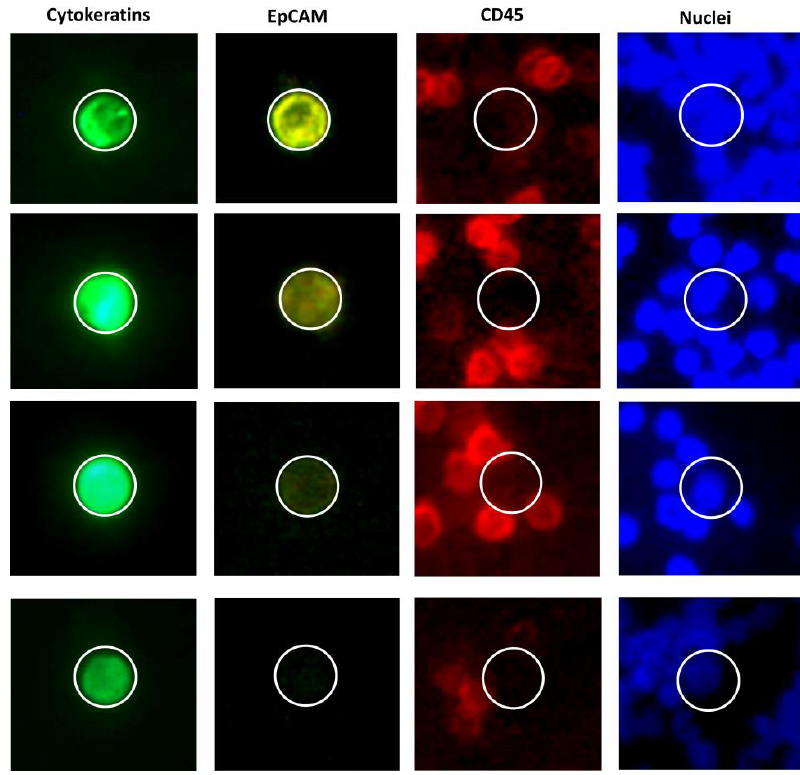
Figure 2. Heterogeneity of EpCAM expression in CTCs in metastatic breast cancer (luminal). Every set of images (Cytokeratins [pan-CK, EpCAM, CD45, nuclei [DAPI]) represents a CTC derived from a different patient. Most of the cytokeratin-positive cells have at least slight microscopically-detectable EpCAM expression, but there is also a population of EpCAM-negative CTCs. Images taken using EpCAM-independent CytoTrack system (unpublished, Malgorzata Szostakowska-Rodzos).